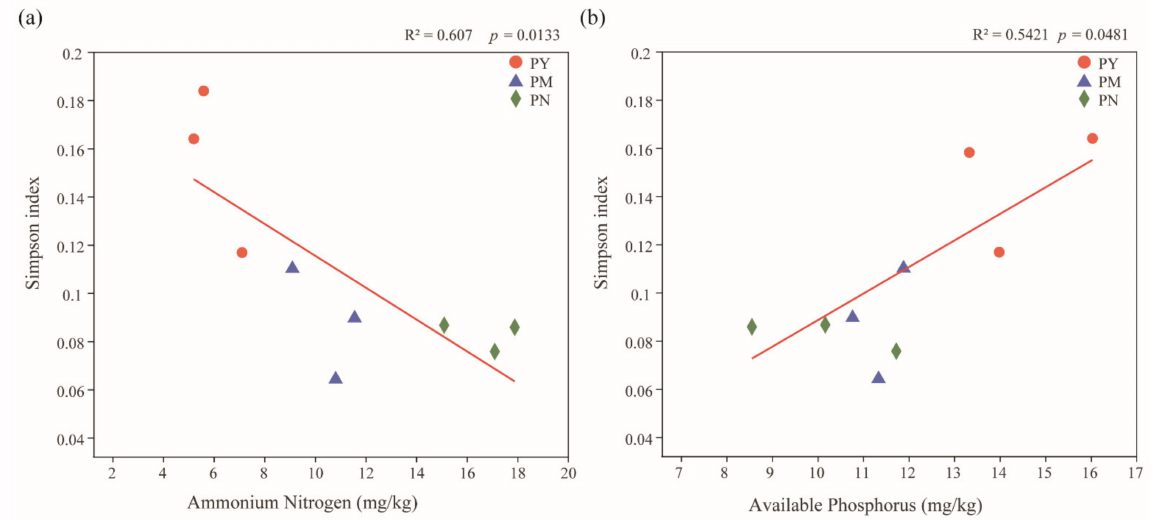
Figure 2. The correlation of rhizosphere soil fungal Simpson index with soil ammonium nitrogen ( a ) and available phosphorus ( b ) at different stand ages. The level of fit and the significance of the relationships are shown in the top right corner of the panels. PY: young forest (10a), PM: middle-aged forest (20a), and PN: near-mature forest